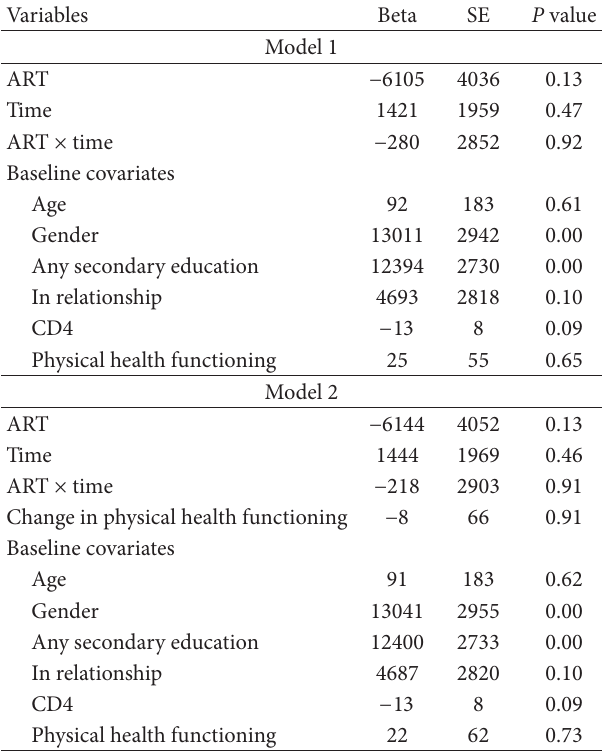
T 3: Multivariate linear regression examining ART impact on weekly